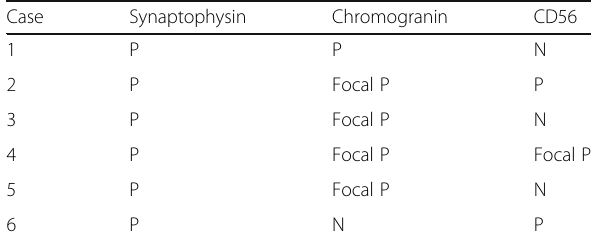
Table 2 Immunohistochemical staining of neuroendocrine markers